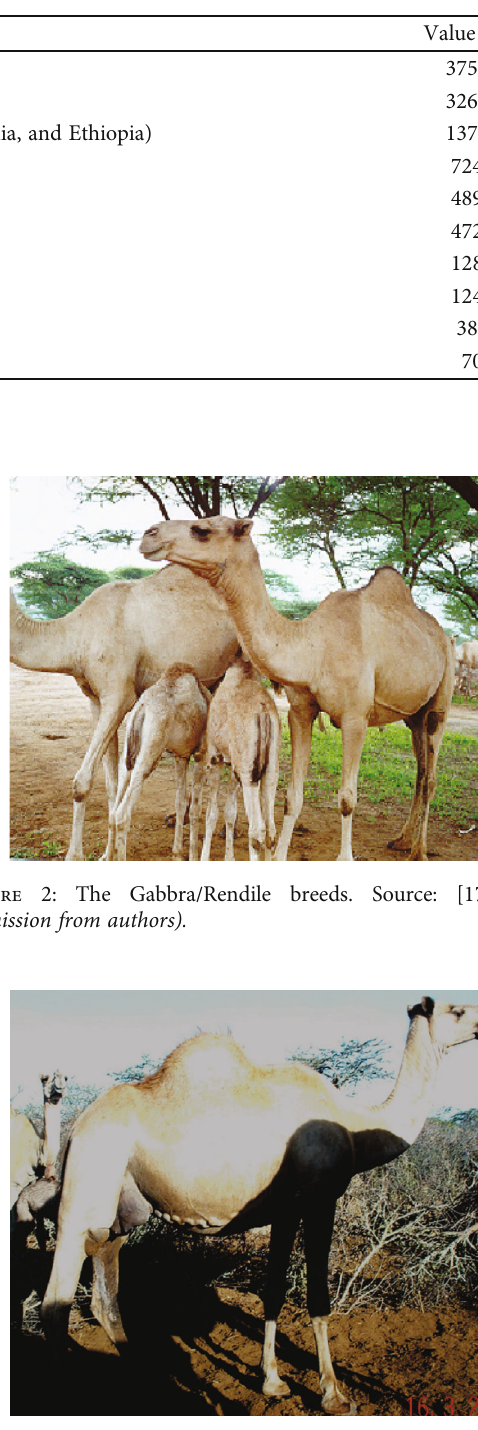
Table 1: Approximate camel population in di ff erent countries (2019).